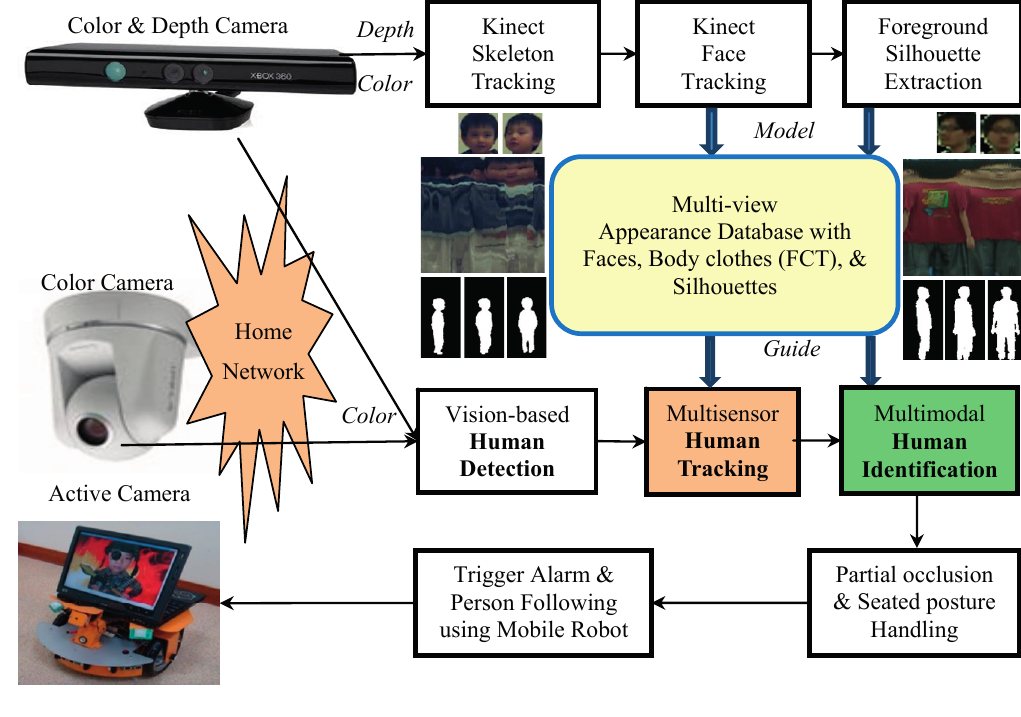
Figure 1. Framework of the proposed appearance-based multimodal human detection, tracking, and identification system for intelligent healthcare and security in digital